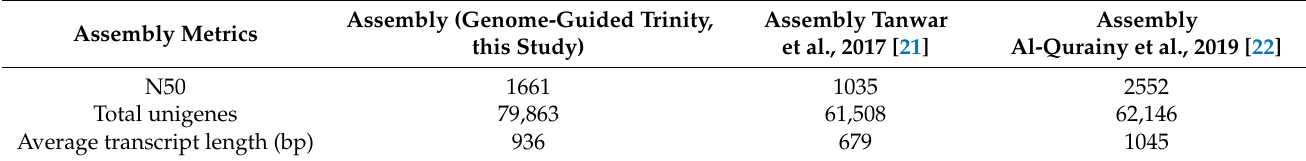
Table 3. Comparative statistics of transcriptome assemblies available for